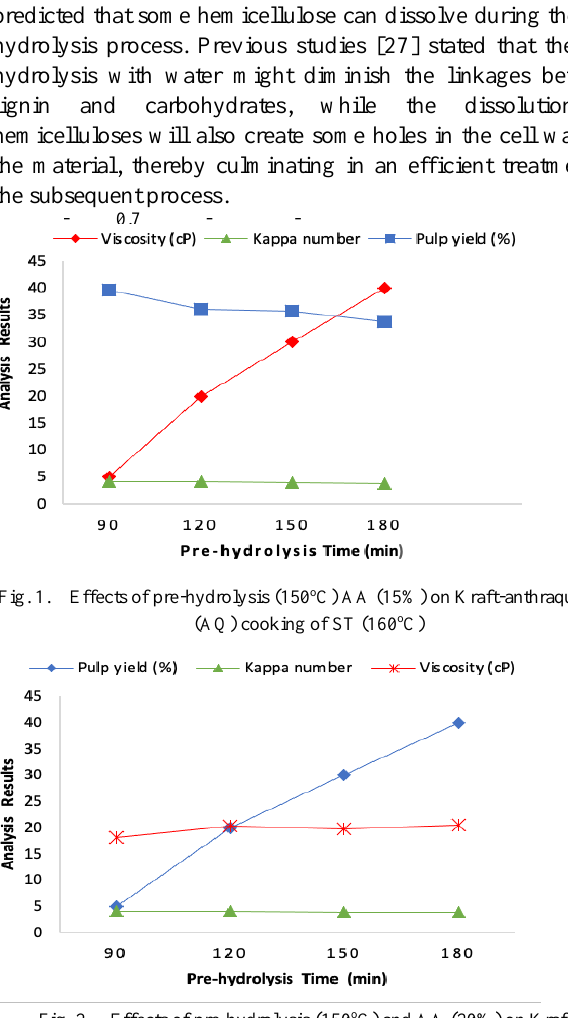
Fig. 2. Effects of pre-hydrolysis (150 o C) and AA (20%) on Kraft- anthraquinone (AQ) cooking of ST (160 o